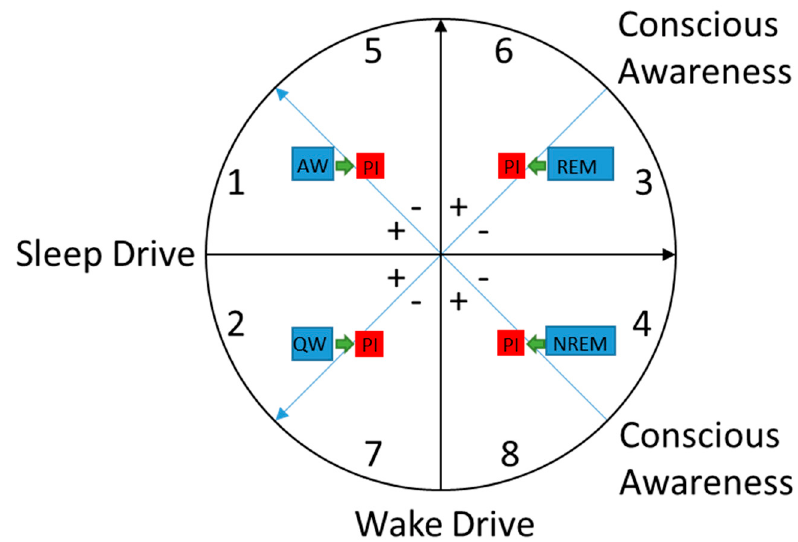
Figure 3. A heuristic model of sleep-wake states. In this model global states are represented in 2-dimensional space based on three major factors: sleep drive, wake drive, and level of conscious awareness. The black arrow pointing toward the top of the circle represents greater wake drive. The black arrow pointing toward the right of the circle represents greater sleep drive. The two blue-lined arrows pointing to the left side of the circle represent higher conscious awareness. To help visualize the conscious awareness factor in relation to the other two factors in the model, the + symbols represent sectors where conscious awareness is higher and the − symbols represent sectors where conscious awareness is lower. Healthy states are indicated by the blue boxes. Healthy active wakefulness (AW) occurs in sector 1 and healthy quiet wakefulness (QW) occurs in sector 2. Healthy rapid-eye movement (REM) sleep occurs in sectors 3 and healthy non-rapid eye-movement (NREM) sleep occurs in sector 4. States experienced by patients with primary insomnia (PI) are indicated by the red boxes. The green arrows represent the hypothesized state shifts experienced by patients with PI relative to good sleepers. Patients with PI may have altered states across sleep-wake states due to reduced activation in brain regions involved in conscious awareness during the wake states and heightened brain activation in these regions during sleep.